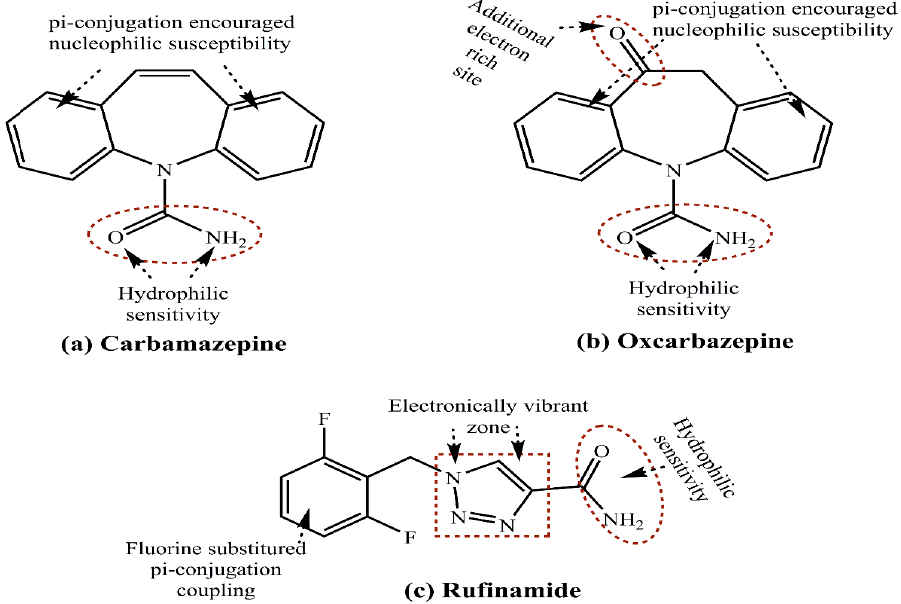
Figure 7. Structural distinctions of ( a ) carbazepine, ( b ) oxacarbazepine and ( c ) rufinamide. The presence of amide functionality in all these drugs provides a structure–activity-based understanding of their antiepileptic